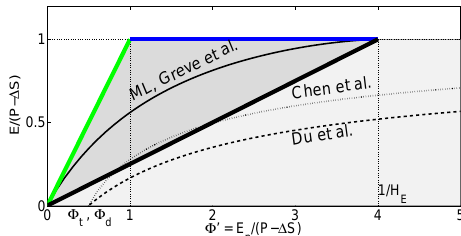
Figure 7. In the space [ E p / ( P − (cid:49)S ), E / ( P − (cid:49)S )], an example comparing the three formulations: Du et al. (2016) with ω = 1.5 and (cid:56) d = 0.5; Chen et al. (2013) with λ = ω − 0 . 72 = 0.78 and (cid:56) t = (cid:56) d = 0.5; the ML formulation for (cid:49)S ≤ 0 (Eq. 14a) with ω = 1.5 and H E = 0.25 (identical to Greve et al. 2016 formulation). The feasible domain of the ML formulation in dark grey is super- imposed over the domains of both Chen et al. (2013) and Du et al. (2016) in light